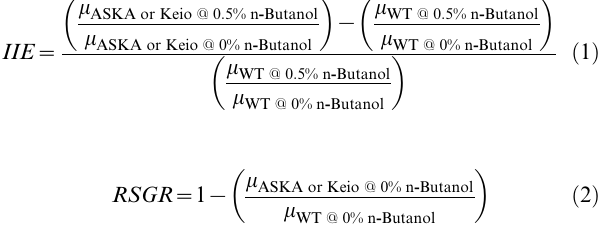
Figure S1 n-Butanol challenge strategy. The library was serially transferred in batch cultures with increasing n-butanol concentration. Control serial transfers in the absence of n-butanol was